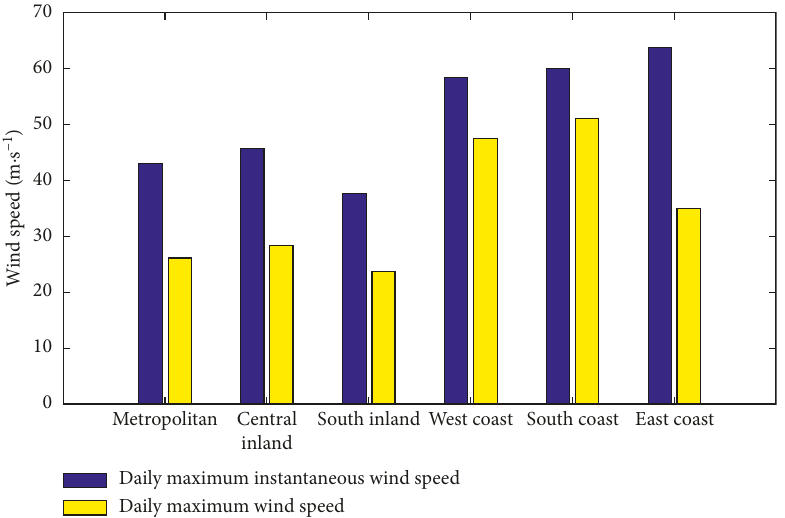
Figure 4: Comparisons of maximum values of the daily maximum instantaneous wind speed (dark blue) and daily maximum wind speed (yellow) in the six